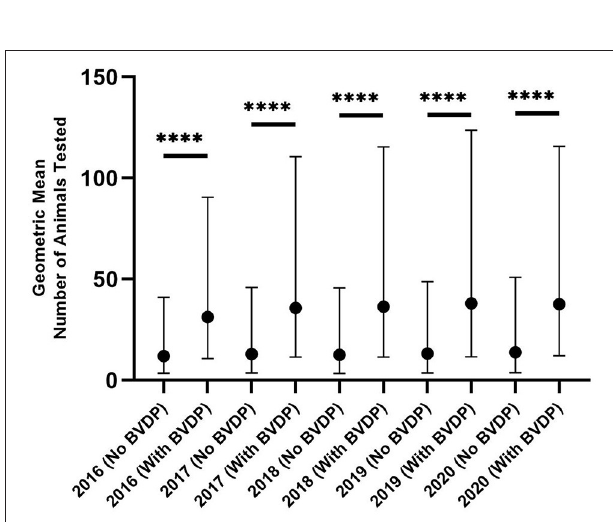
FIGURE 5 | The number of animals tested per herd for herds that have and have not disclosed BVDP animals (**** p < 0.0001).